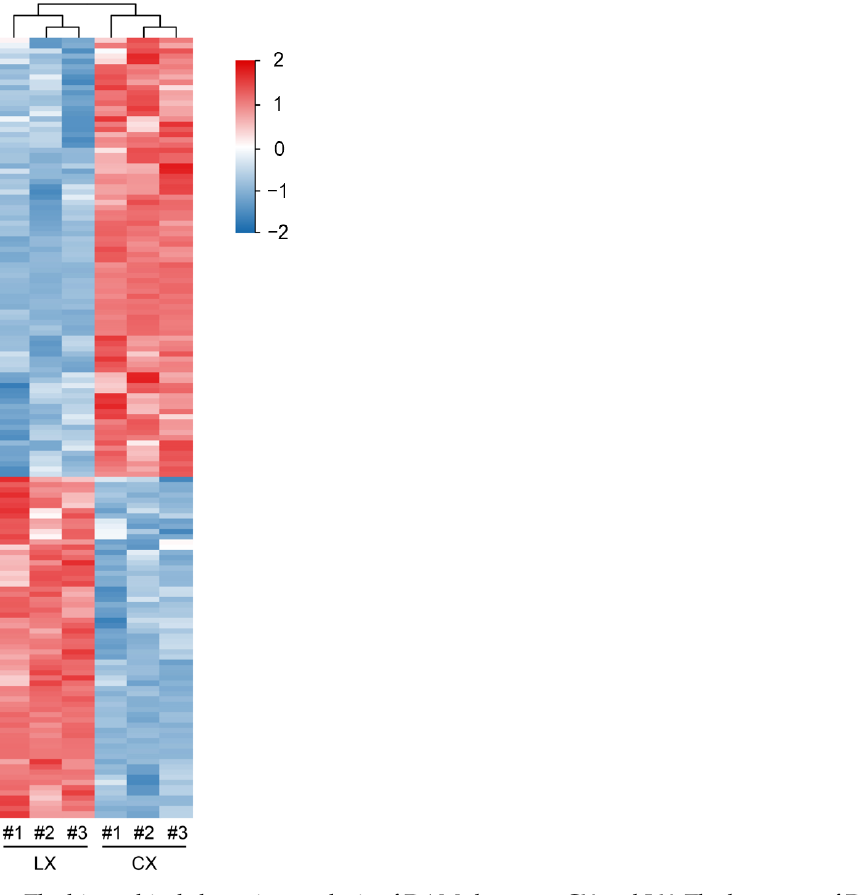
Figure 5. The hierarchical clustering analysis of DAMs between CX and LX. The heatmap of DAMs was displayed by Euclidean distance and complete cluster methods as a measurement of similarity.